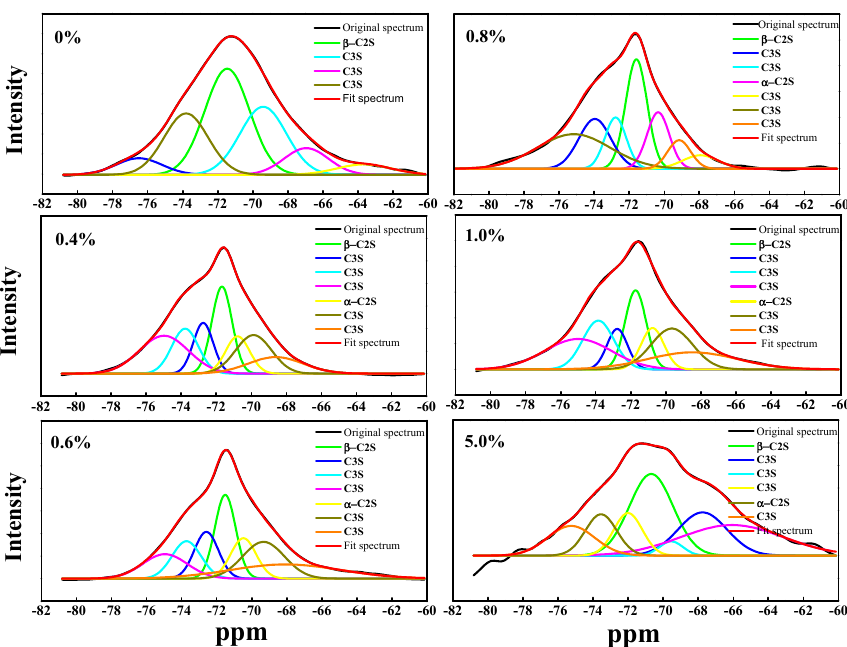
Figure 2. 29 Si MAS NMR spectrum after fitting peaks of di ff erent Cr doping clinker. Table 3. Percentage of β -C 2 S, C 2 S, and C 3 S after peak fitting / wt %.